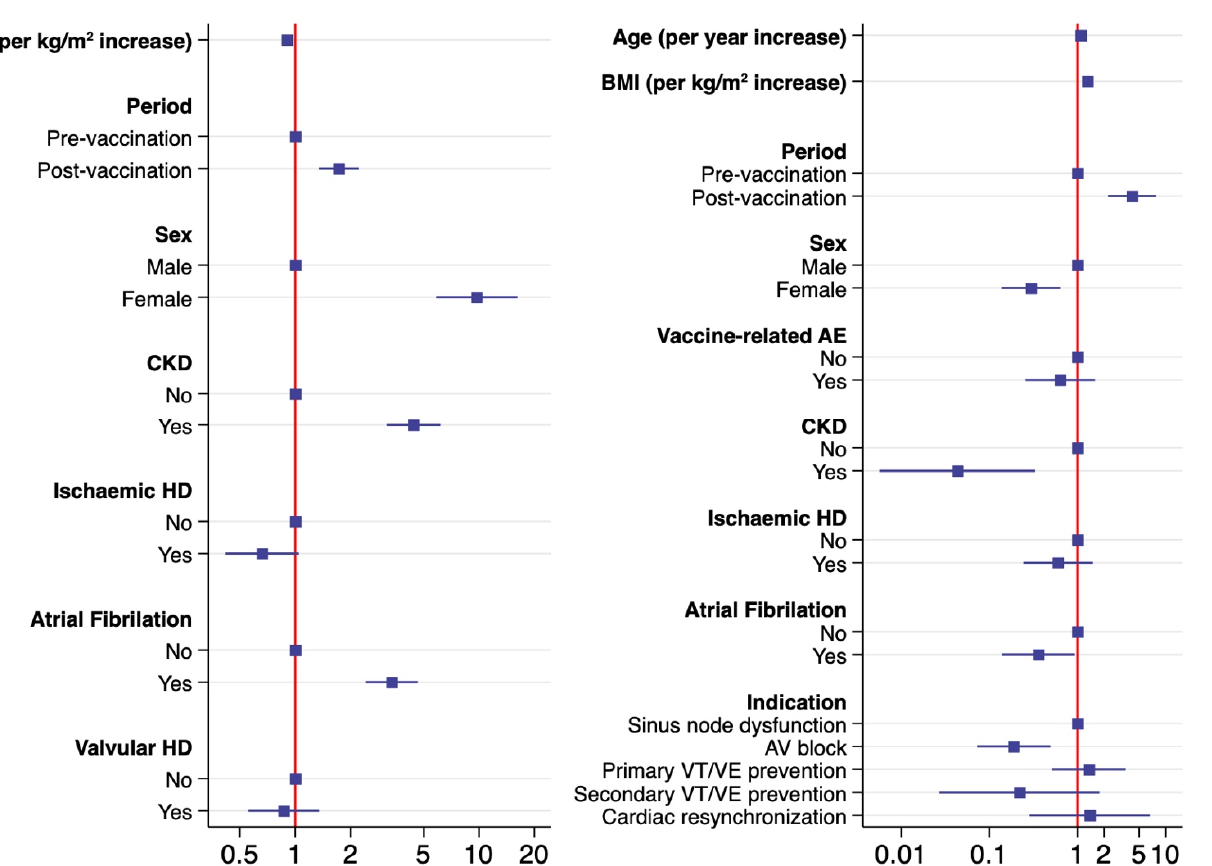
Figure 1. Factors associated with SVT and VA